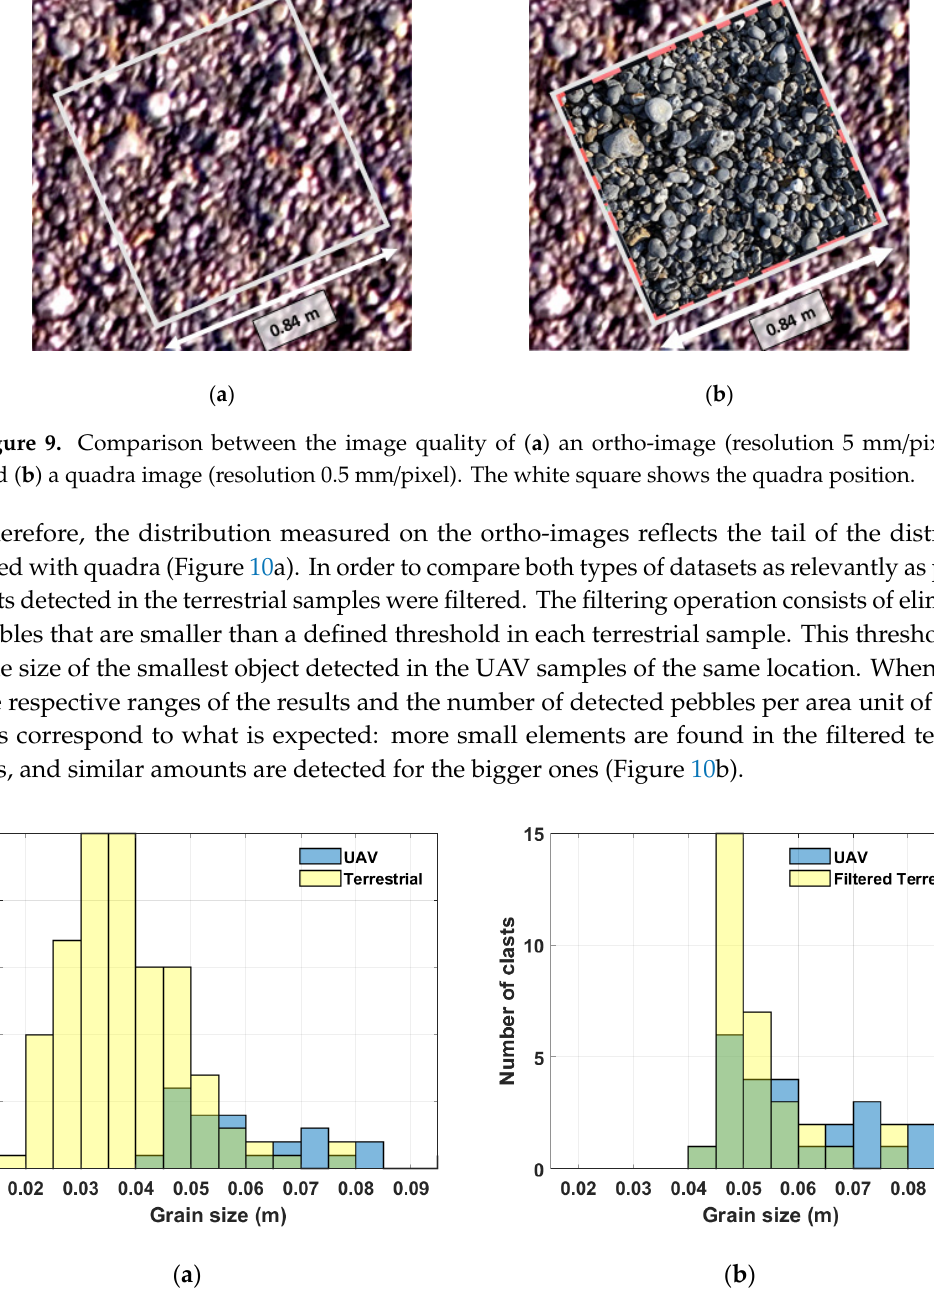
Figure 10. Comparison between the clast size distribution of a terrestrial sample (yellow) with a UAV sample (blue) at the same location, ( a ) before and ( b ) after applying the filtering processing.